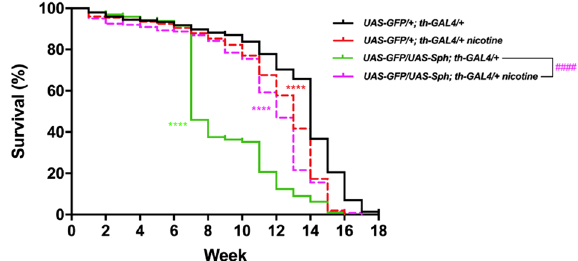
Figure 1. Nicotine treatment increases lifespan in Sph-1 expressing flies, while reduces it in control animals. Lifespan in control animals (that do not express Sph-1) is reduced when treated with 24 µM nicotine. Flies expressing Sph-1 in dopaminergic neurons have a significantly reduced life span (green solid line). However, this is rescued by chronic nicotine treatment (magenta dotted lines). Data of untreated control animals are presented with black solid lines; data of nicotine-treated control animals are graphed with red dotted lines. Statistical analyses were performed using Log-rank (Mantel-Cox) test. Asterisks are used to show statistical significance between the untreated control line ( UAS-GFP/ + ; th-GAL4/ +) and all the other genotypes and conditions, the number symbol (#) is used to show statistical significance between the treated and untreated Sph-1 lines ( UAS- GFP/UAS-Sph; th-GAL4/ +) **** or #### P < 0.0001, n = 200 animals per experimental condition. All treated animals were chronically exposed to 24 µM